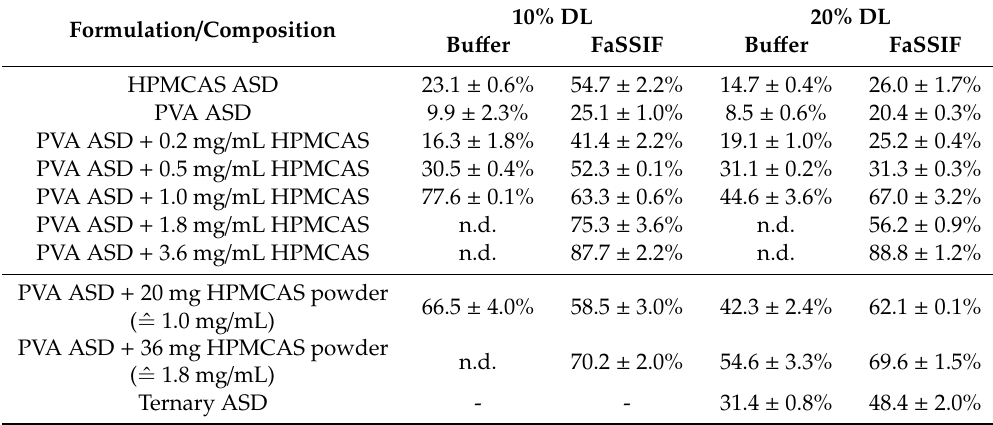
Table 2. Relative area under the dissolution curve.